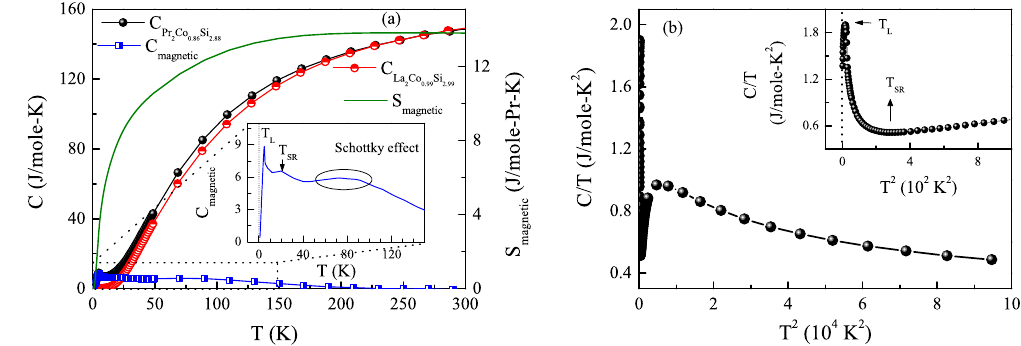
Figure 9. (a) Zero-field heat capacity of Pr 2 Co 0.86 Si 2.88 , its non-magnetic counterpart La 2 Co 0.99 Si 2.99 , along with the magnetic component in heat capacity of the former (left panel) and magnetic entropy (right panel) as a function of temperature. Inset shows the expanded view of magnetic contribution for a limited range of temperature. (b) Heat capacity data in the form of C / T as a function of T 2 . Inset shows the expanded view in the low temperature region.